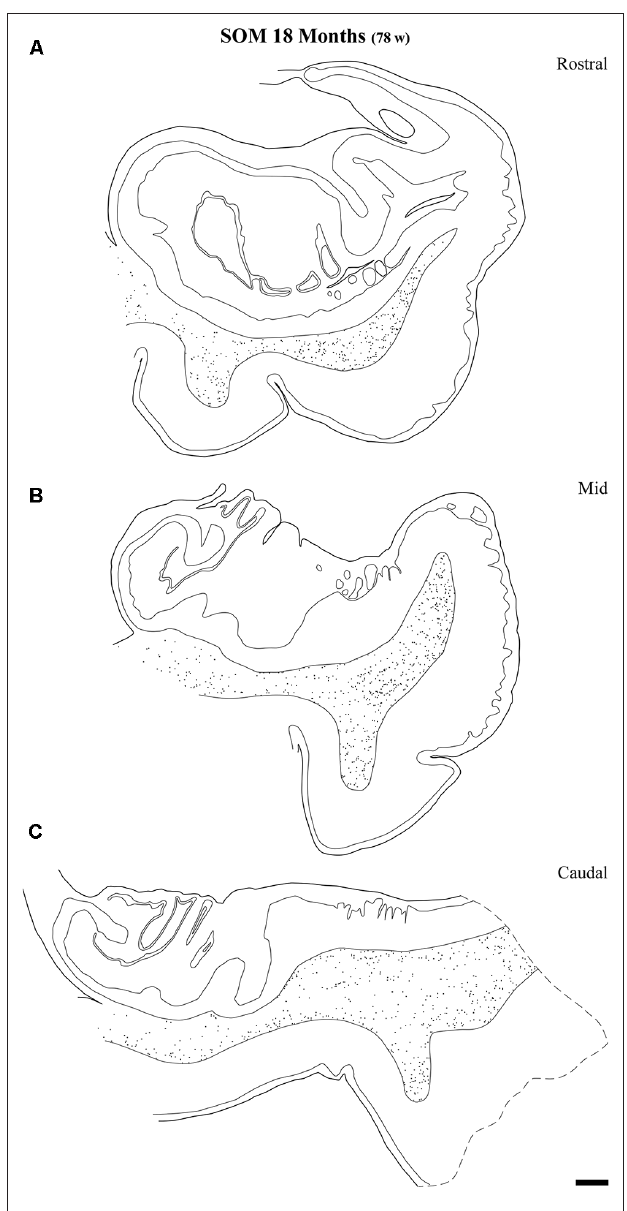
FIGURE 10 | Distribution of SOM-28-positive neurons at three rostrocaudal levels of the angular bundle at 18 months. Note the relative higher density rostral at midlevel. Conventions as in Figure 3 . Scale bar is 2